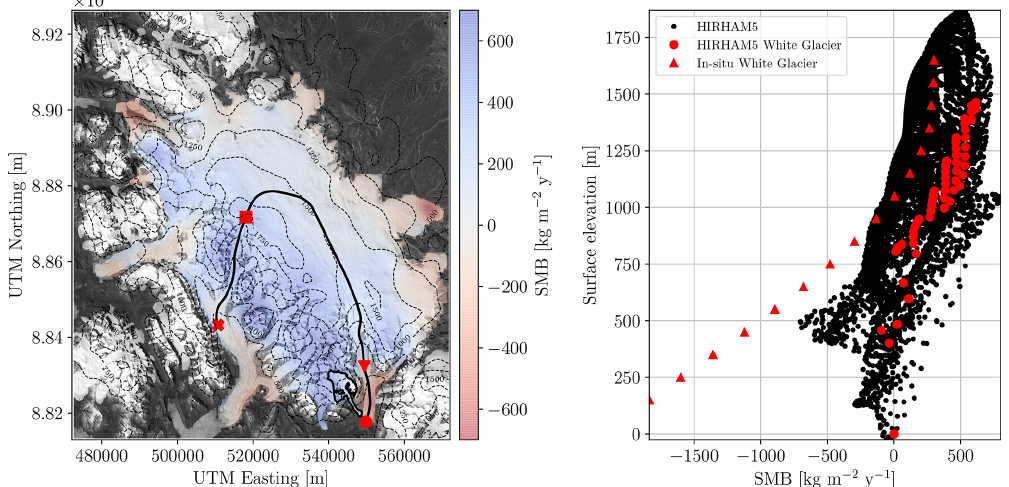
Figure 1. Left: Landsat 8 satellite image of the Müller Ice Cap overlaid with long-term average HIRHAM5 surface mass balance (SMB) from 1980–2016. Contour lines of surface elevation from ArcticDEM with 250m increments, and the Operation IceBridge flight line as the solid black line from the red dot to the red cross. The four red symbols have the same location as in Fig. 3 and are present to guide the reader. White Glacier is outlined in black just above the red dot. The coordinates are given in UTM zone 15N. Right: surface mass balance as a function of surface elevation. Red triangles are average in situ measurements from White Glacier from 1960–91 (Cogley et al., 1996). The black and red dots are long-term HIRHAM5 SMB averages from 1980–2016, with the red dots corresponding to the SMB within the White Glacier